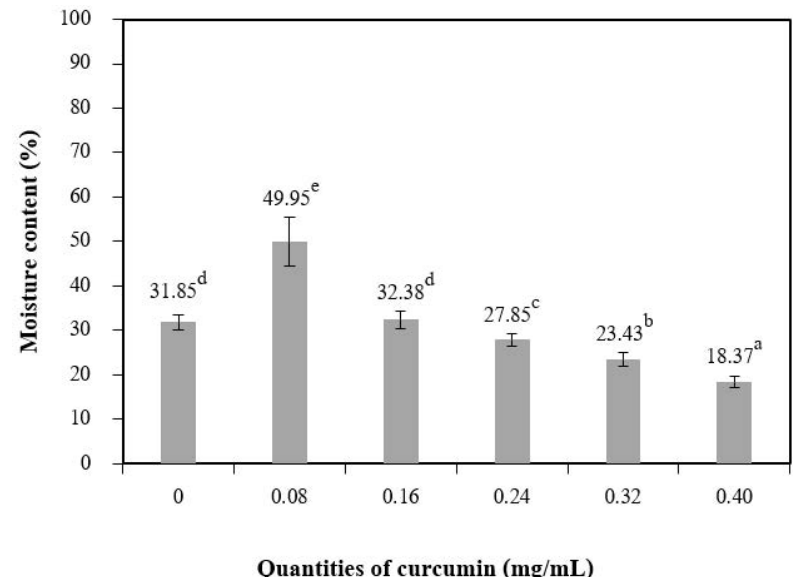
Figure 4. The moisture content of chitosan film incorporated with various curcumin quantities. Results marked with different letters are statistically different ( p <